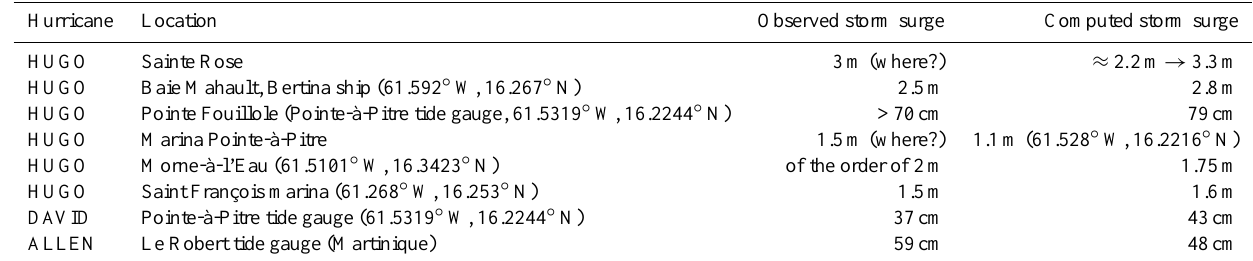
Table 2. Comparison of observed and computed storm surges for different hurricanes (see Fig. 2 for location). Hurricane